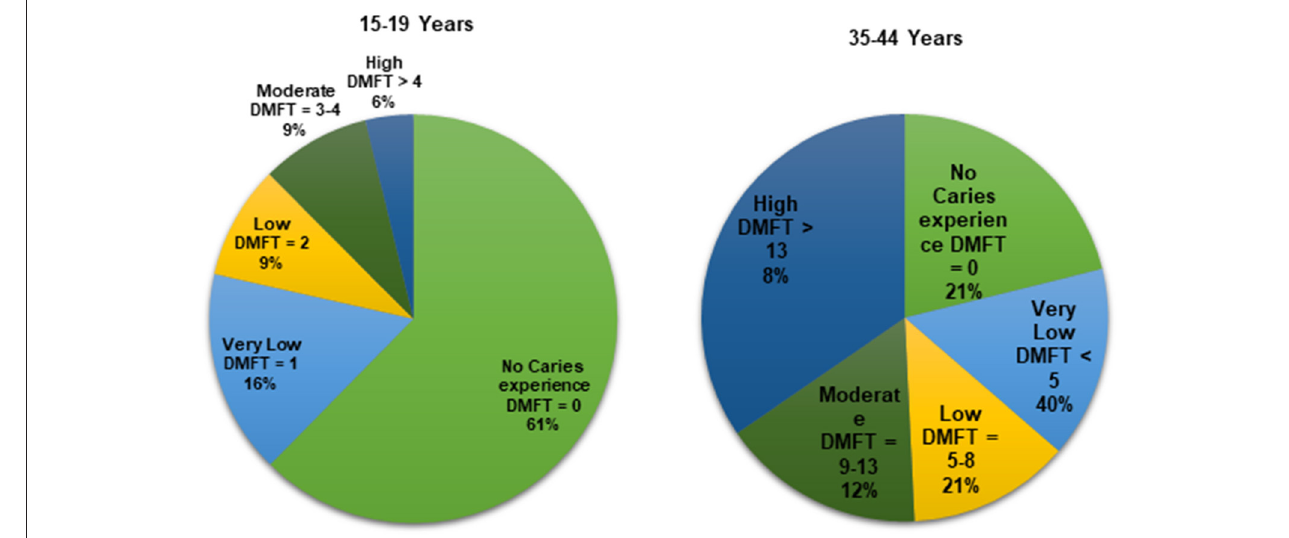
FIGURE 1 | Study participants’ DMFT value.